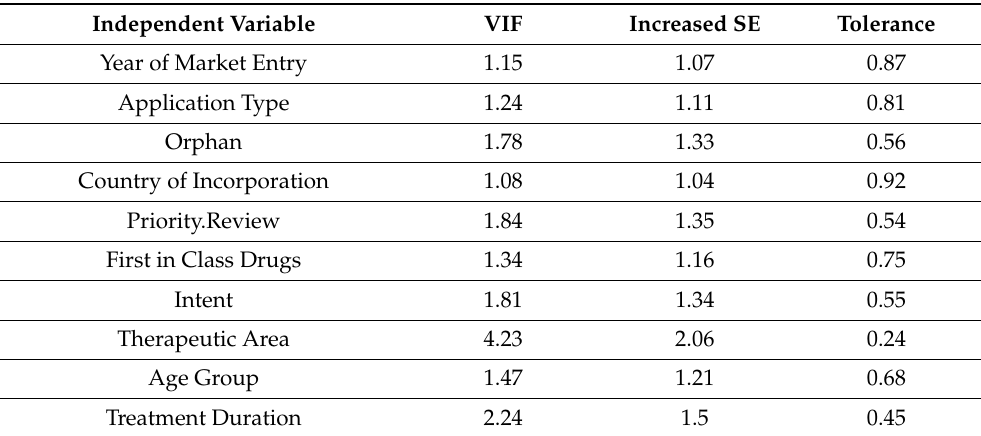
Table A3. Multicollinearity.